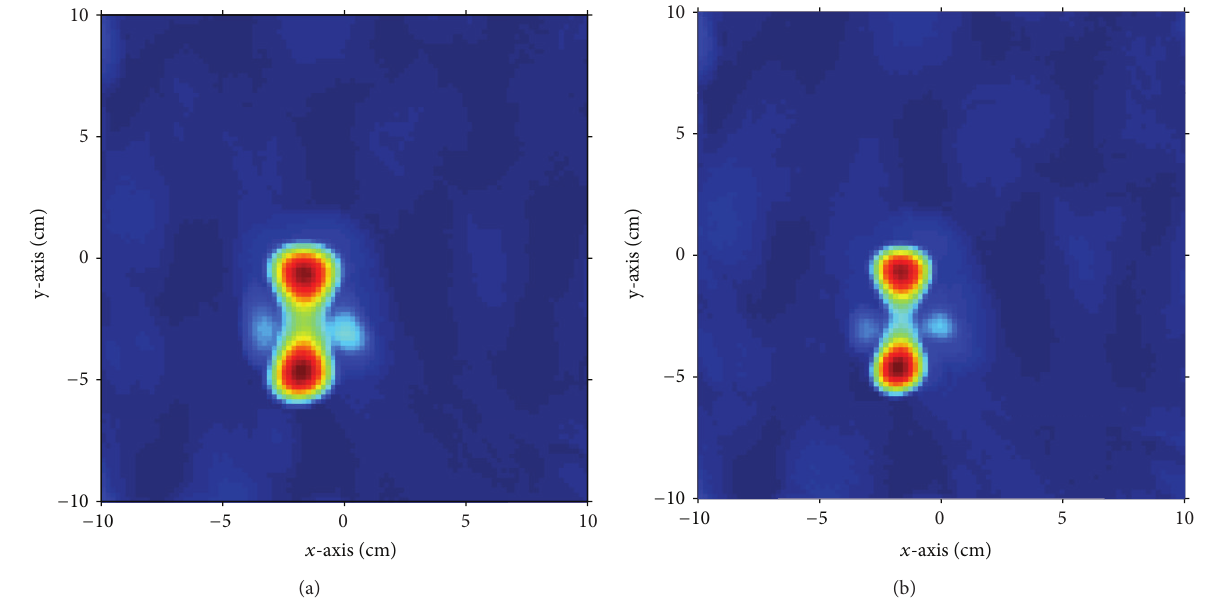
Figure 5: Reconstruction of two nylon rods. The figure shows the reconstruction differences when using 𝜇 = 1 (a) and 𝜇 = 1.4 (b).